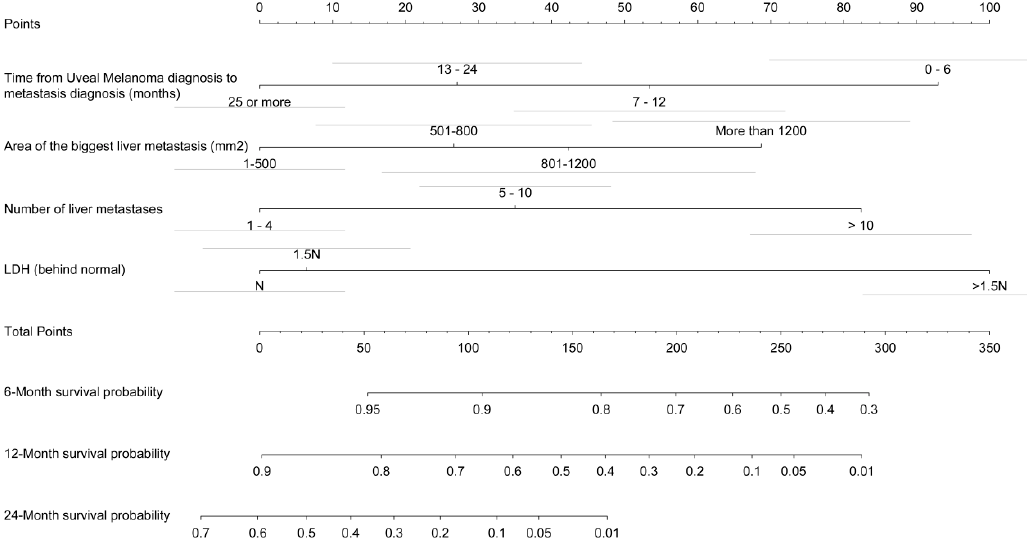
Figure 2. Calibration curves at 6, 12, and 24 months. Estimate of calibration accuracy was performed using adaptive spline regression. The line adjacent to the ideal line corresponds to the apparent predictive accuracy. The blue line corresponds to corrected estimates. 3. Discussion